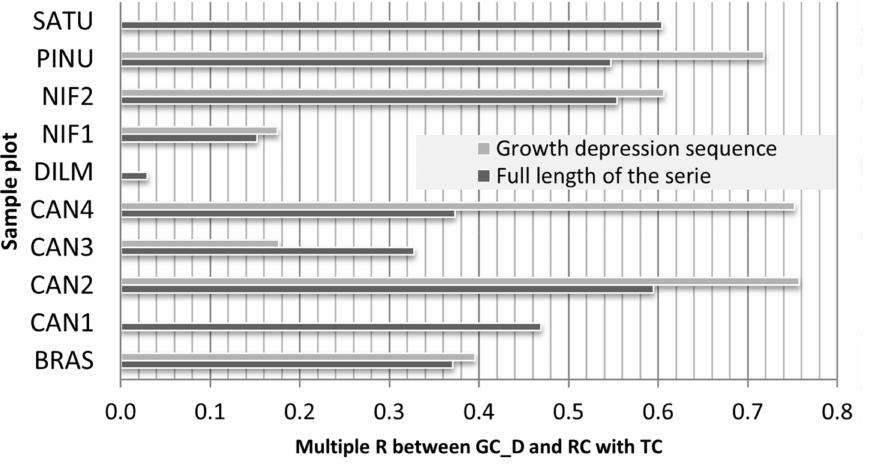
Figure 5. Verifying the growth response to the